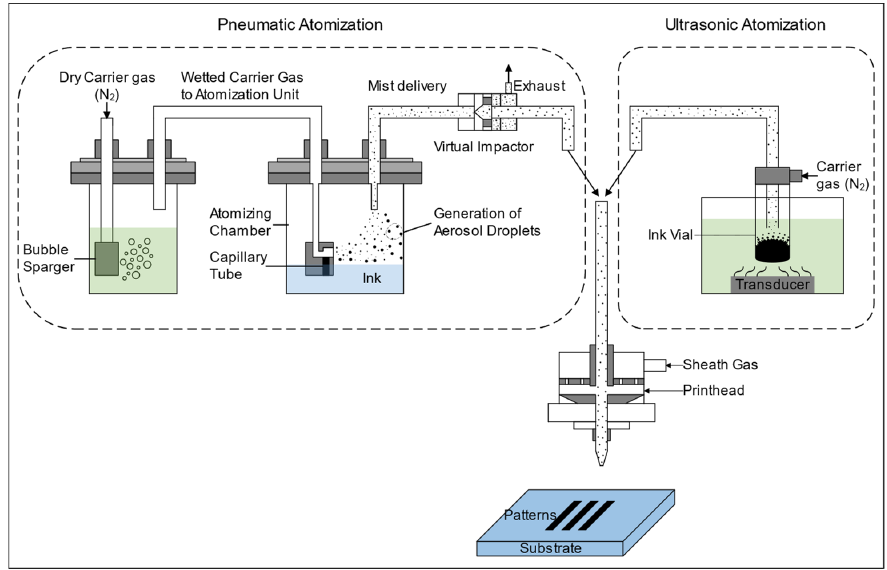
Figure 6. Schematics of AJP with both a pneumatic atomizer and ultrasonic